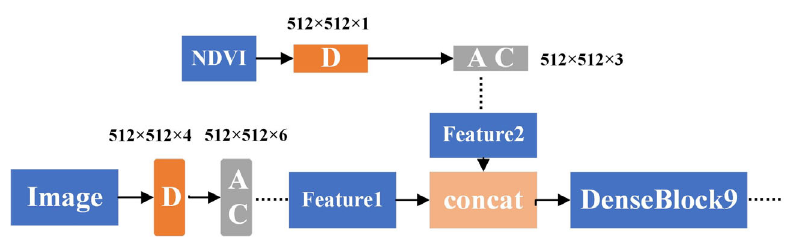
Figure 2. Structure of NDVI fusion module.